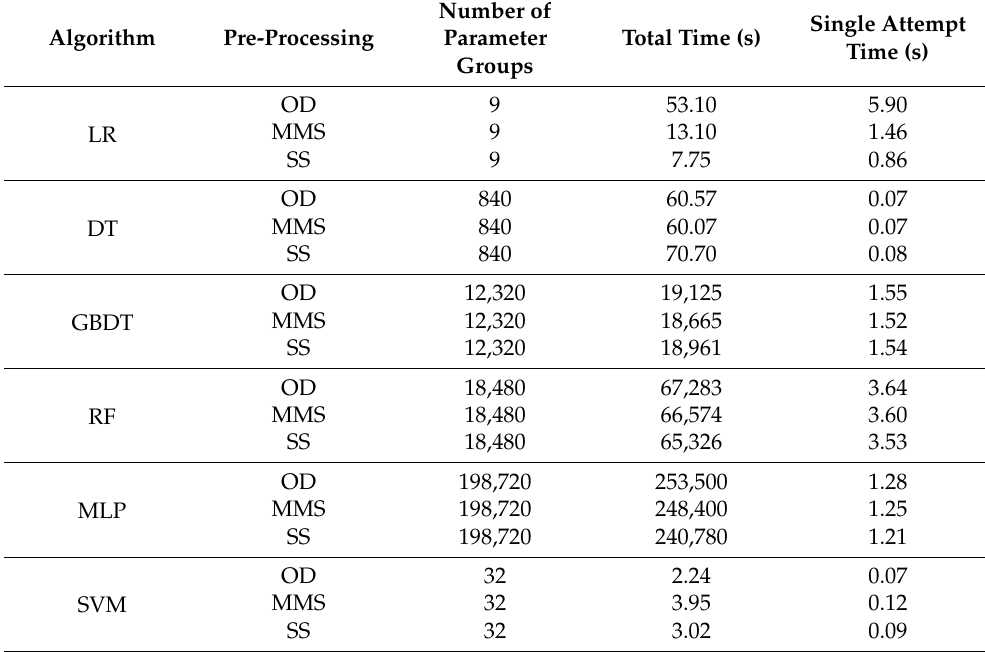
Table 4. Time consumption summary of training models based on the GridSearchCV method.